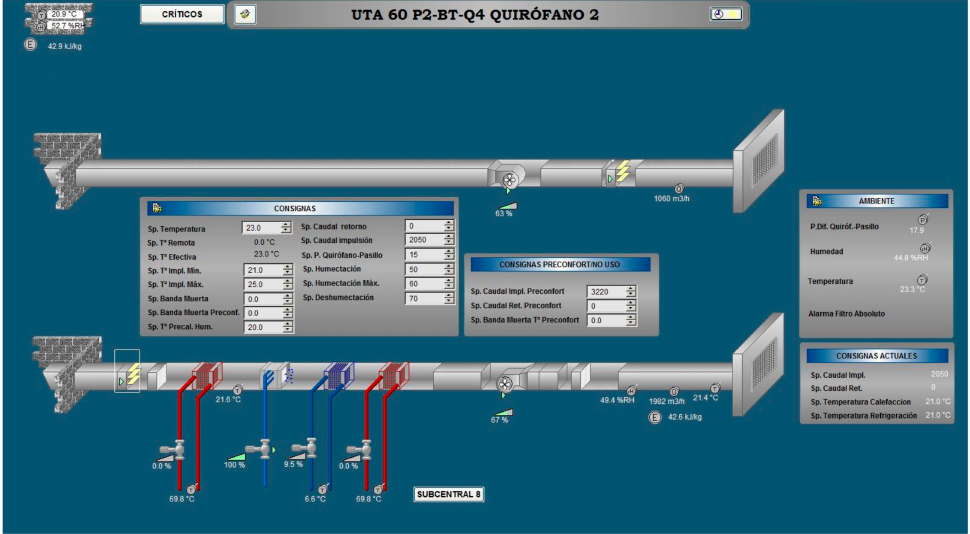
Figure 2. Interface of the SIEMENS’ SCADA showing the main parameters of AHU